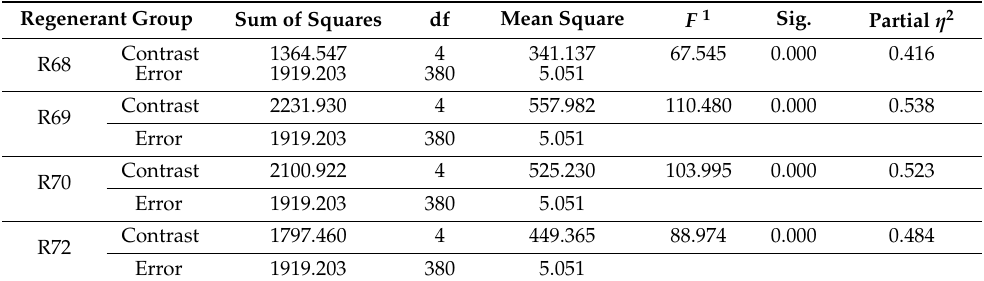
Table 4. The arrangement of simple main effects describing differences in mean sequence variation scores of the regenerant groups, derived from four donor plants by TE families, was evaluated based on univariate tests at α = 0.05.